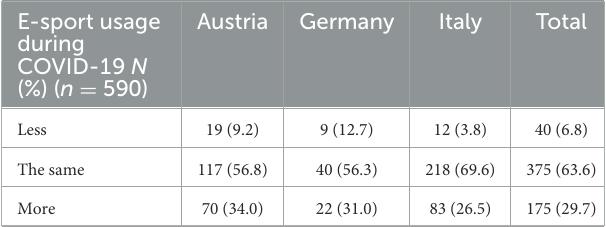
TABLE 4 Use of e-sports during the COVID-19 pandemic in the Alpine regions of Austria, Germany and Italy. E-sport usage during COVID-19 N (%) ( n =